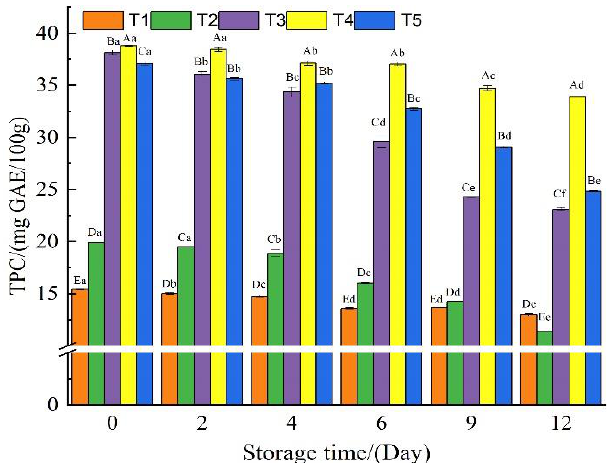
Figure 3. The total phenolic content of beef samples from different treatment groups during storage.